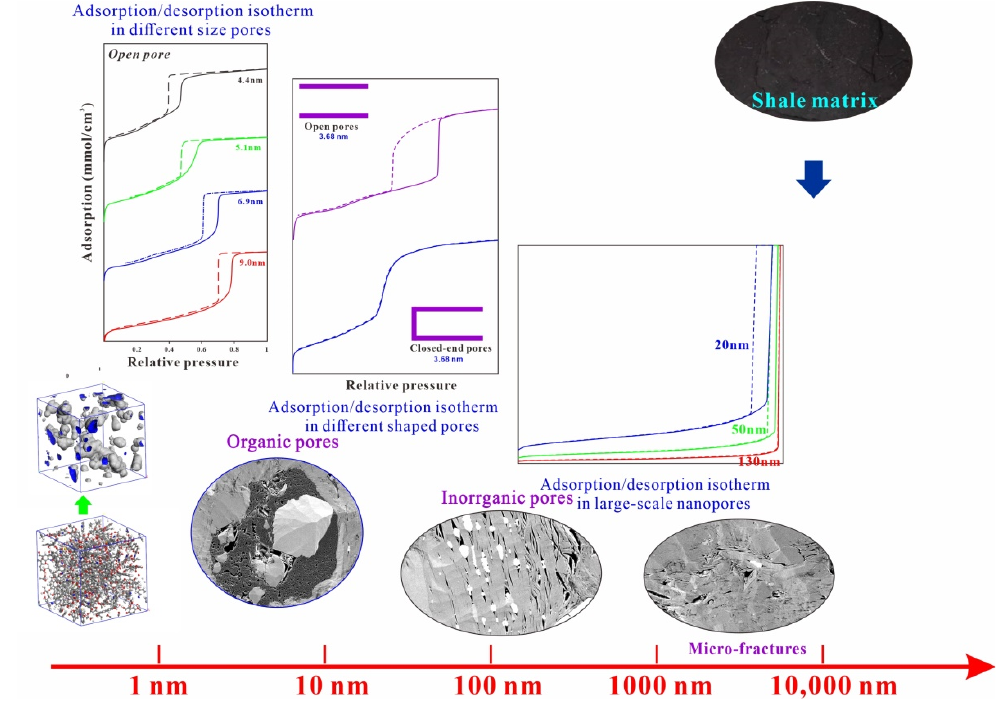
Figure 7. Adsorption and desorption loops in different sized and different shaped ideal pores